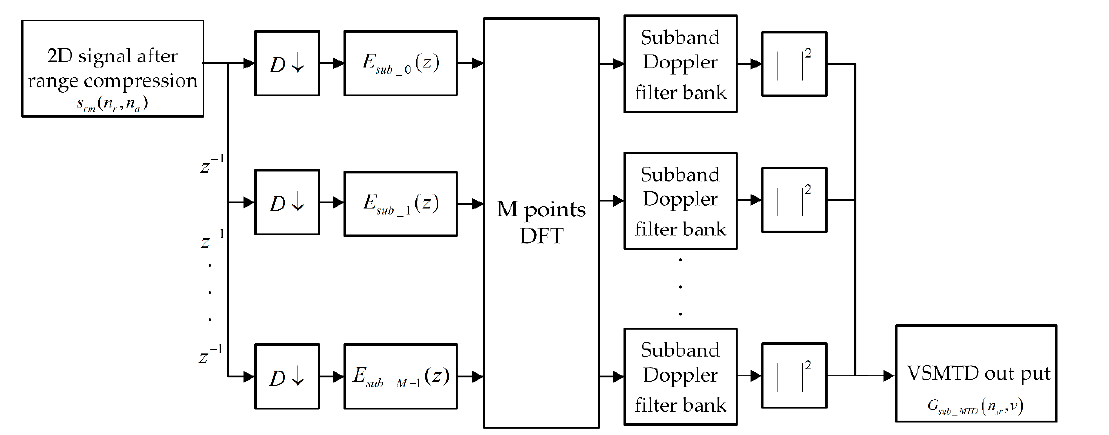
Figure 13. Efficient implementation of VSMTD.